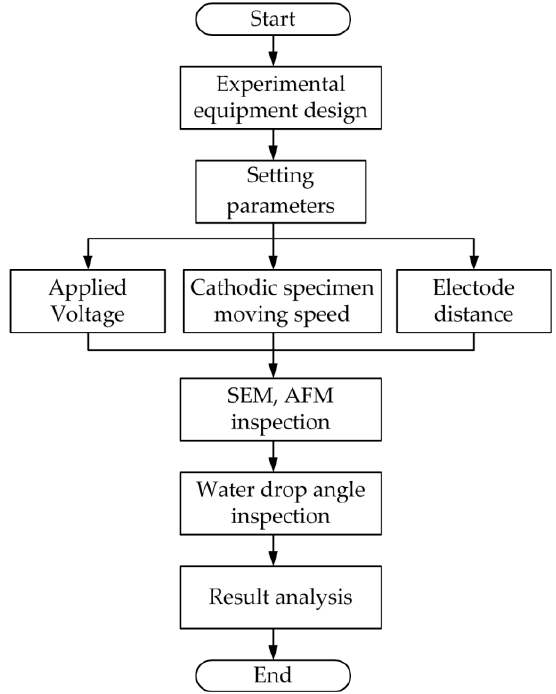
Figure 1. Flowchart of the experimental procedure; AFM: atomic force microscopes